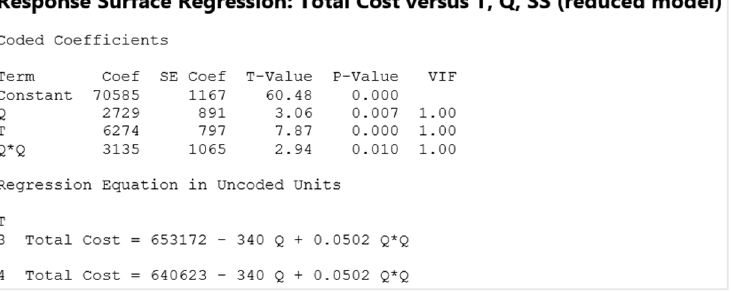
Figure 9. CCD—response surface regression of TC versus T, Q, and SS (reduced model).